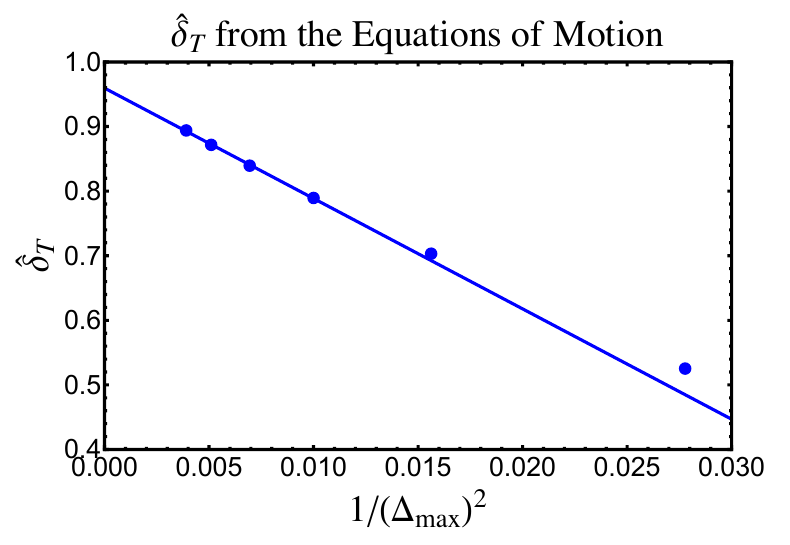
ˆ δ T (as defined in (5.9) and (5.13)) for different values of ∆ max . The values, ˆ δ 0 . 96 − 17 max T ≈ ∆ 2 max